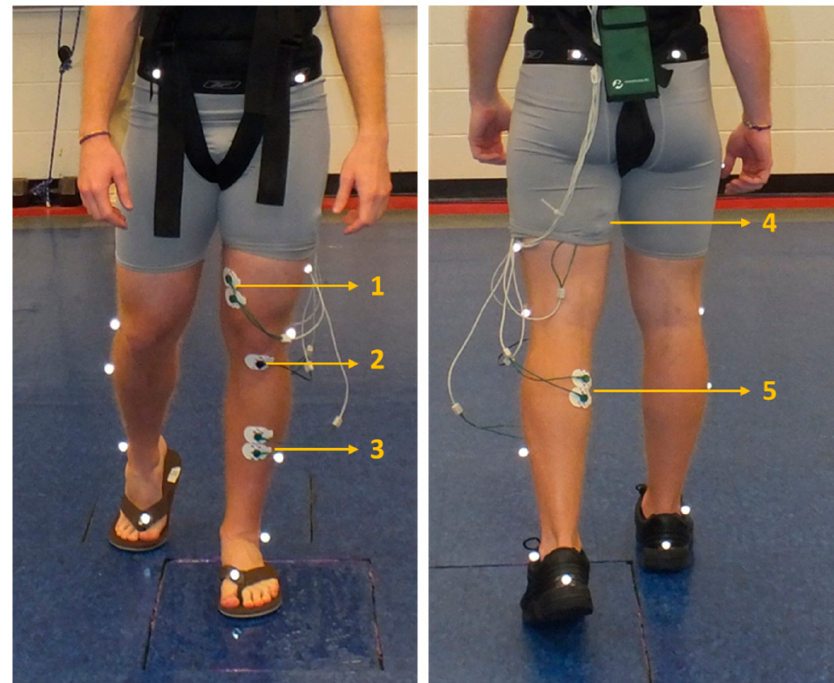
Figure 2. Example of a participant performing the gait-slip trials in flip-flops (FF) ( left ) and low top slip resistant show (LT) ( right ) along with the lower extremity muscles tested. ( 1 ) Vastus medialis (VM). ( 2 ) Ground electrode on tibial tuberosity. ( 3 ) Tibialis anterior (TA). ( 4 ) Medial hamstrings (MH). ( 5 ) Medial gastrocnemius (MG).